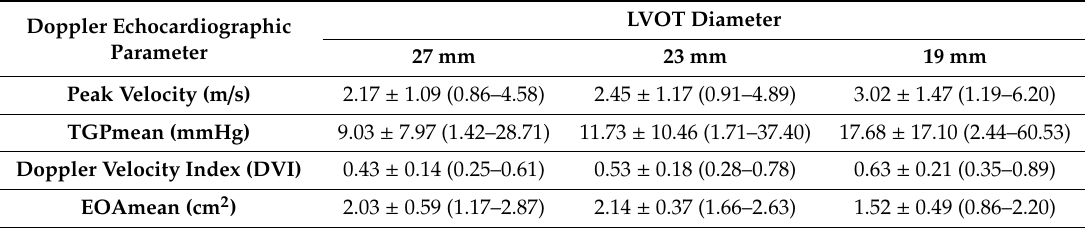
Table 1. Doppler echocardiographic parameters (range) as a function of LVOT diameter for di ff erent flow rates and deferent severities of BMHV dysfunctions.